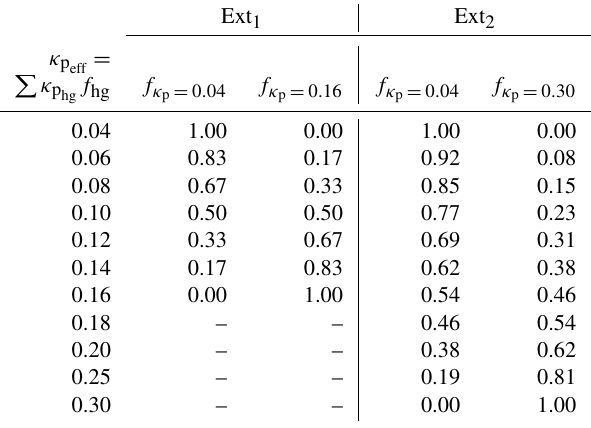
Table 2. Number fractions for the hygroscopic groups in the exter- nally mixed populations Ext 1 and Ext 2